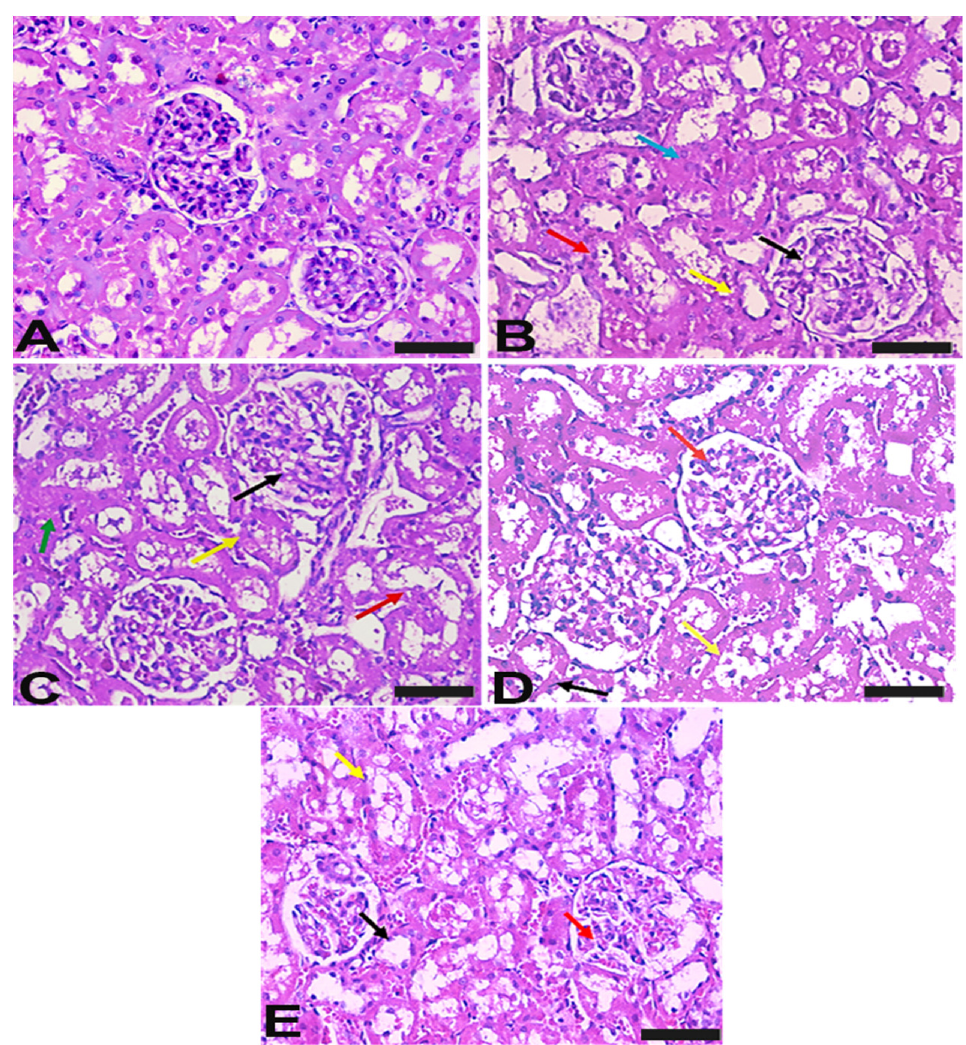
normal glomerulus and tubules and reversed the pathological changes associated with HgCl 2 administration.